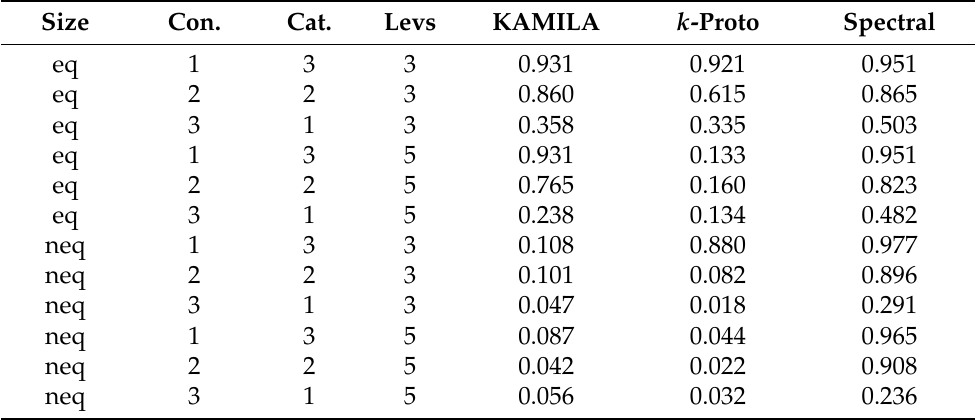
Table 2. Median ARI for low overlap in continuous variables and high overlap in categorical variables, n = 100 two-cluster data sets.